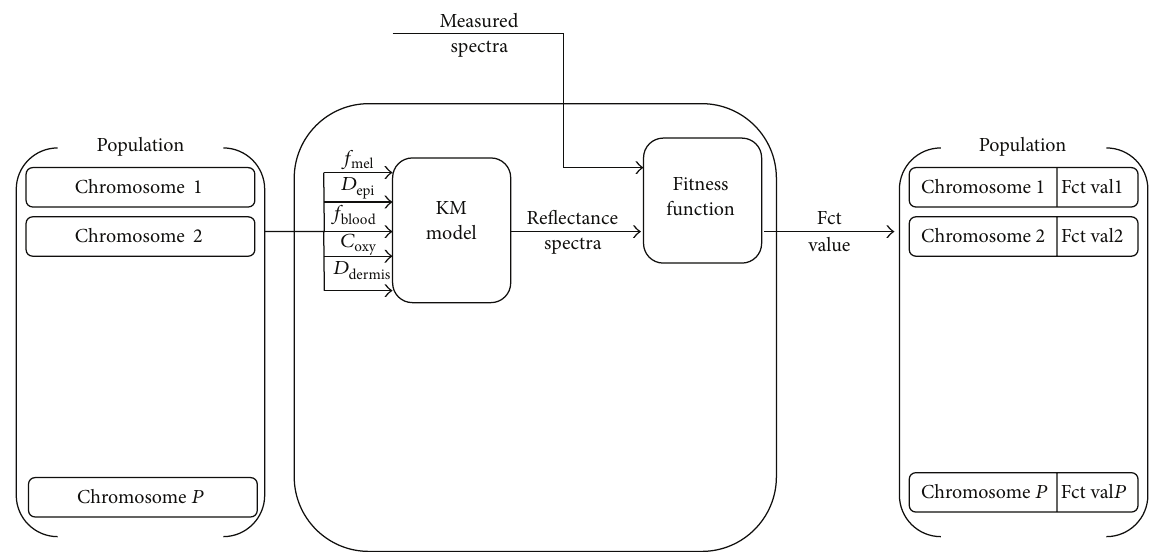
Figure 6: GA fitness function GA. Each chromosome of the population is used to simulate a reflectance spectrum. The simulated reflectance spectrum is compared with the measured one. The fitness function outputs a value corresponding based on the similarity between the two spectra. The fitness value is then used to classify the